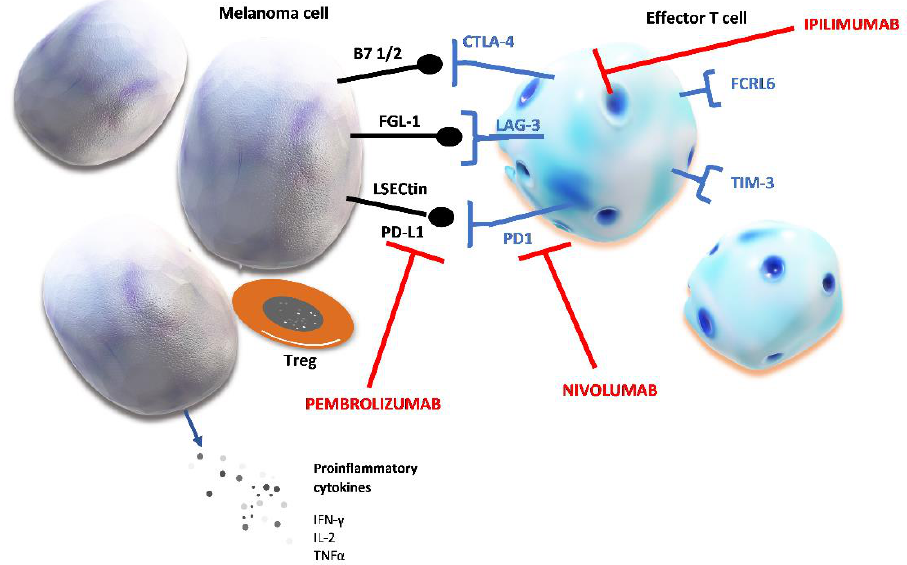
Figure 1. Chronic stimulation of T cells and markers of T cell exhaustion. Prolonged tumor neoantigen stimulation causes the upregulation of several inhibitory proteins. Checkpoint proteins expressed on effector T cells are: cytotoxic T-lymphocyte – associated antigen 4 (CTLA-4), lymphocyte activation gene 3 (LAG-3), programmed cell death protein 1 (PD-1), Fc receptor-like 6 protein (FCRL6), T cell immunoglobulin and mucin domain-containing protein 3 (TIM-3). Their ligands can be expressed on melanoma cell and after binding to their specific receptor, these ligands induce T cell exhaustion which shields tumor cells from host’s immune defense. The figure shows the specific ligands of immune checkpoint proteins: fibrinogen-like protein (FGL-1); liver sinusoidal endothelial cell lectin (LSECtin); programmed death-ligand 1 (PD-L1); peripheral membrane protein found on antigen presenting cells type 1 or 2 (B7 1/2).